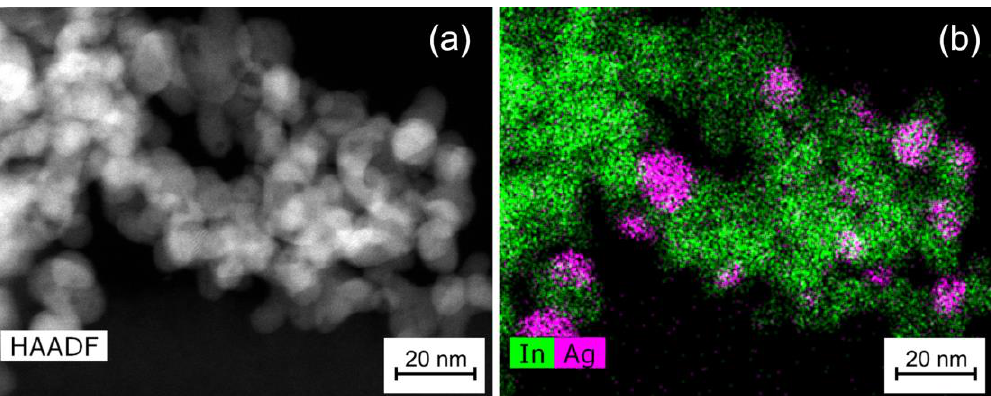
Figure 5. ( a ) HAADF-STEM image and ( b ) energy dispersive X-ray (EDX)maps of In 2 O 3 /Ag-imp nanocomposite.